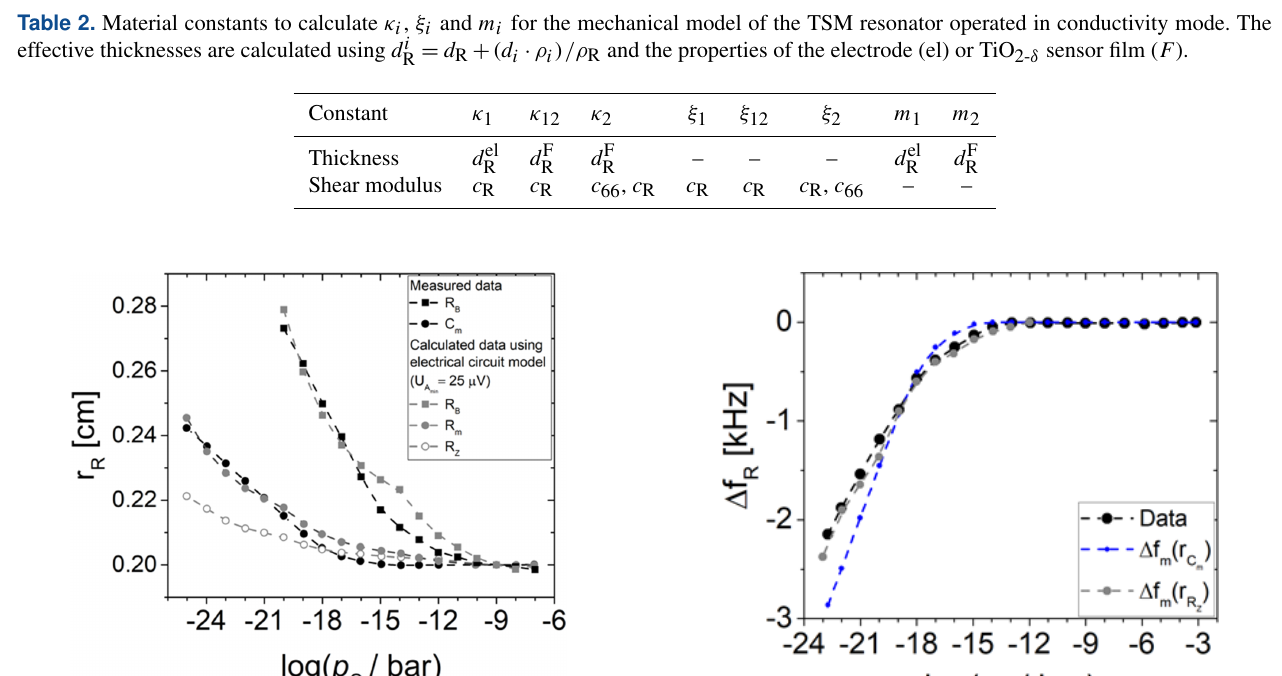
Table 2. Material constants to calculate κ i , ξ i and m i for the mechanical model of the TSM resonator operated in conductivity mode. The